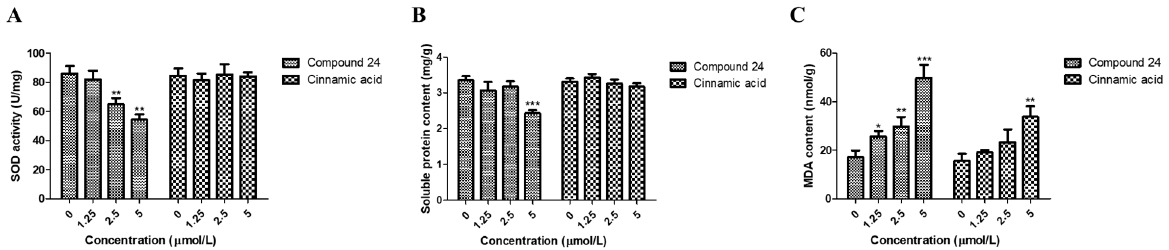
Figure 4. Superoxide dismutase (SOD) activity ( A ), and contents of soluble protein ( B ) and malondialdehyde (MDA) ( C ) in M. aeruginosa after 72-h exposure to compound 24 and CIA (0, 1.25, 2.5, and 5 µmol/L). Data are presented as mean values ± standard deviation (n = 3). * p < 0.05, ** p < 0.01, *** p < 0.001 vs. 0 µmol/L.